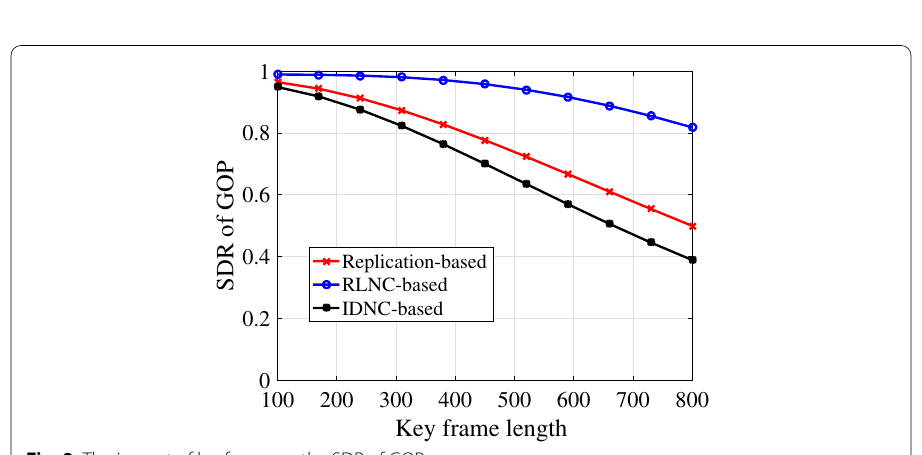
Fig. 9 The impact of keyframe on the SDR of